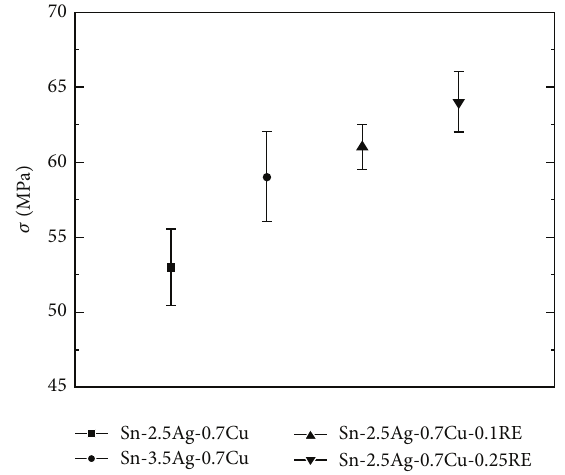
Figure 4: Tensile properties of SAC-RE